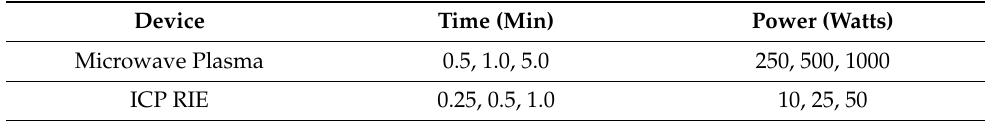
Table 1. Parameter combinations for the oxygen plasma treatments.